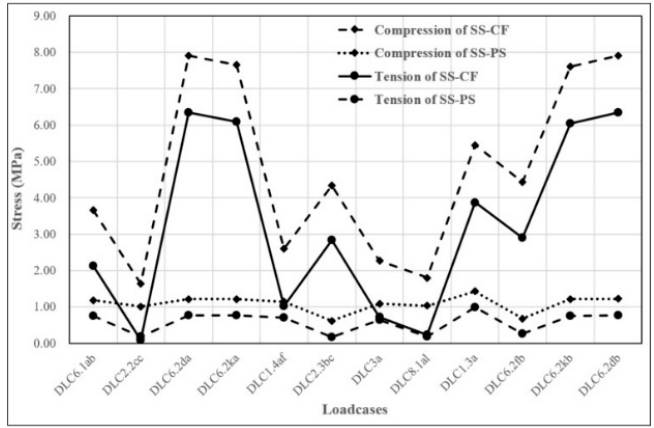
Figure 12. Comparison of stresses in concrete of SS-CF model and SS-PS model.